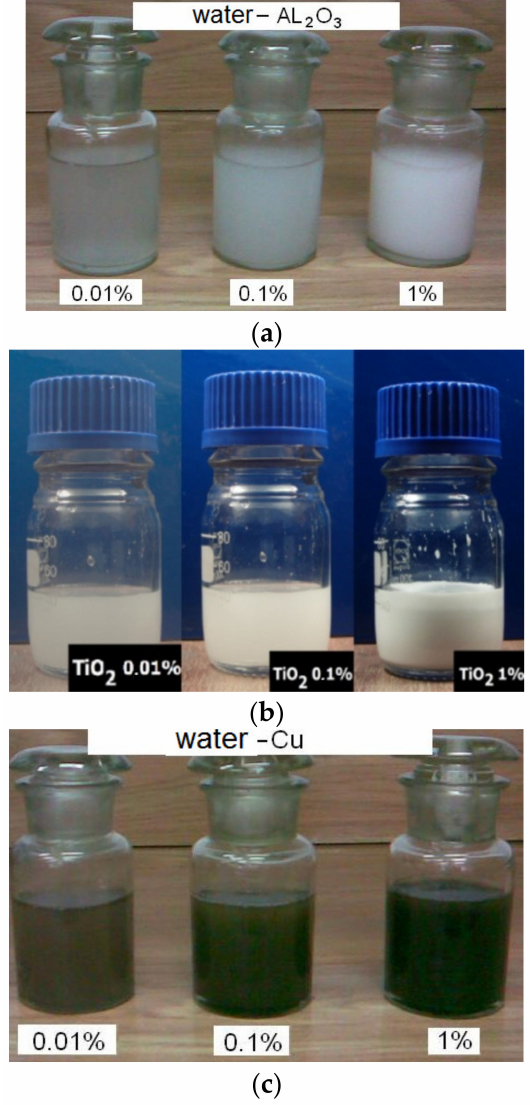
Figure 5. Photographs of the nanofluids tested: ( a ) water–Al 2 O 3 , ( b ) water–TiO 2 , ( c )